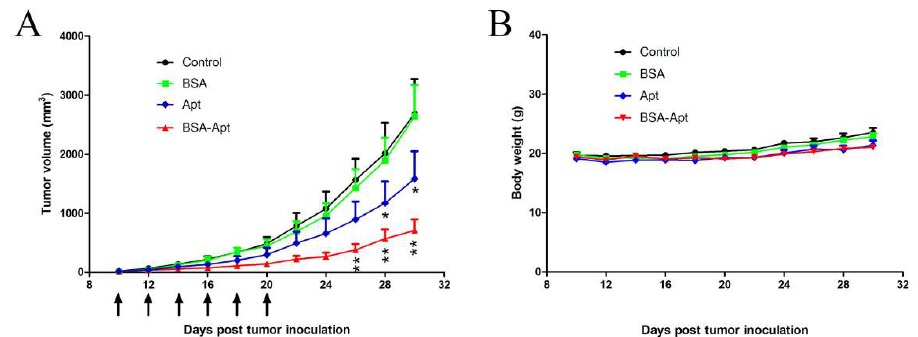
Figure 7. In vivo tumor inhibition by various treatments. CT26-bearing BALB/c mice were divided into four groups, with eight animals in each group. The mice were treated with PBS (control), BSA (1.6 mg/kg), free PD-L1 aptamers (1.2 mg/kg), or BSA-Apt (with BSA of 1.6 mg/kg and aptamer of 1.2 mg/kg). The treatments were administrated by intraperitoneal injections every two days, for a total of six injections (arrows). ( A ) Tumor volume and ( B ) body weight were recorded and shown. Single star indicates statistically significant differences ( p < 0.05) between the free aptamer and the control groups, and double stars indicate significant differences ( p < 0.05) between the free aptamer and the BSA-Apt groups.